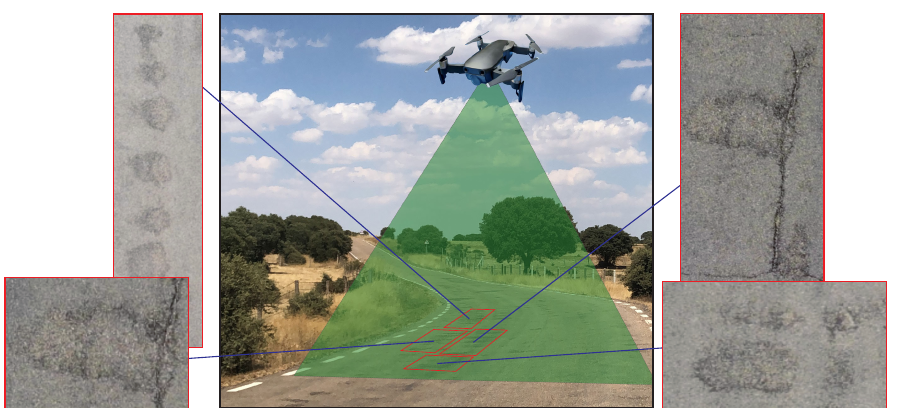
Figure 3. Image data acquisition.